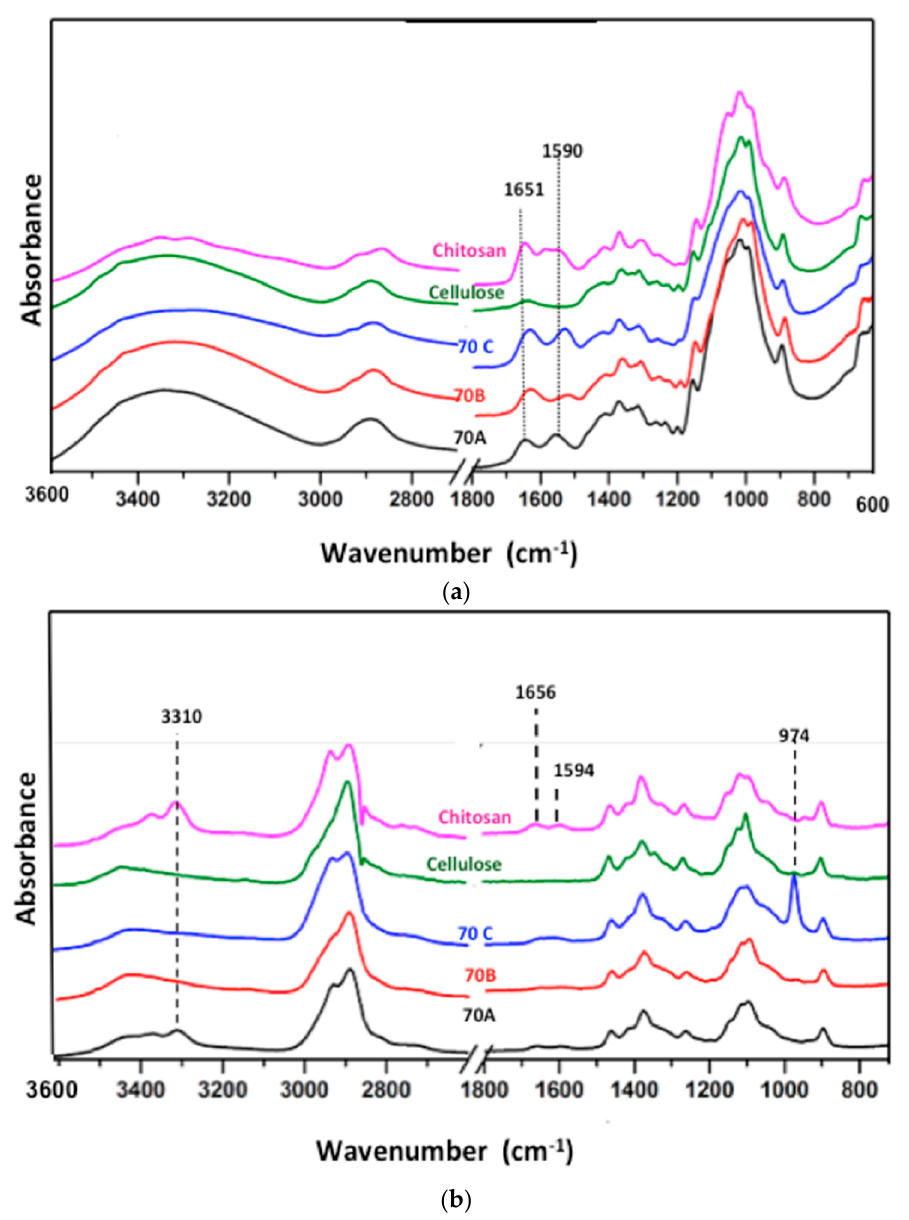
Figure 2. ( a ) Attenuated Total Reflectance–Fourier Transform Infra-Red (ATR-FTIR) and ( b ) Raman spectra of chitosan cellulose and 70A , 70B and 70C lyophilized hydrogel beads.